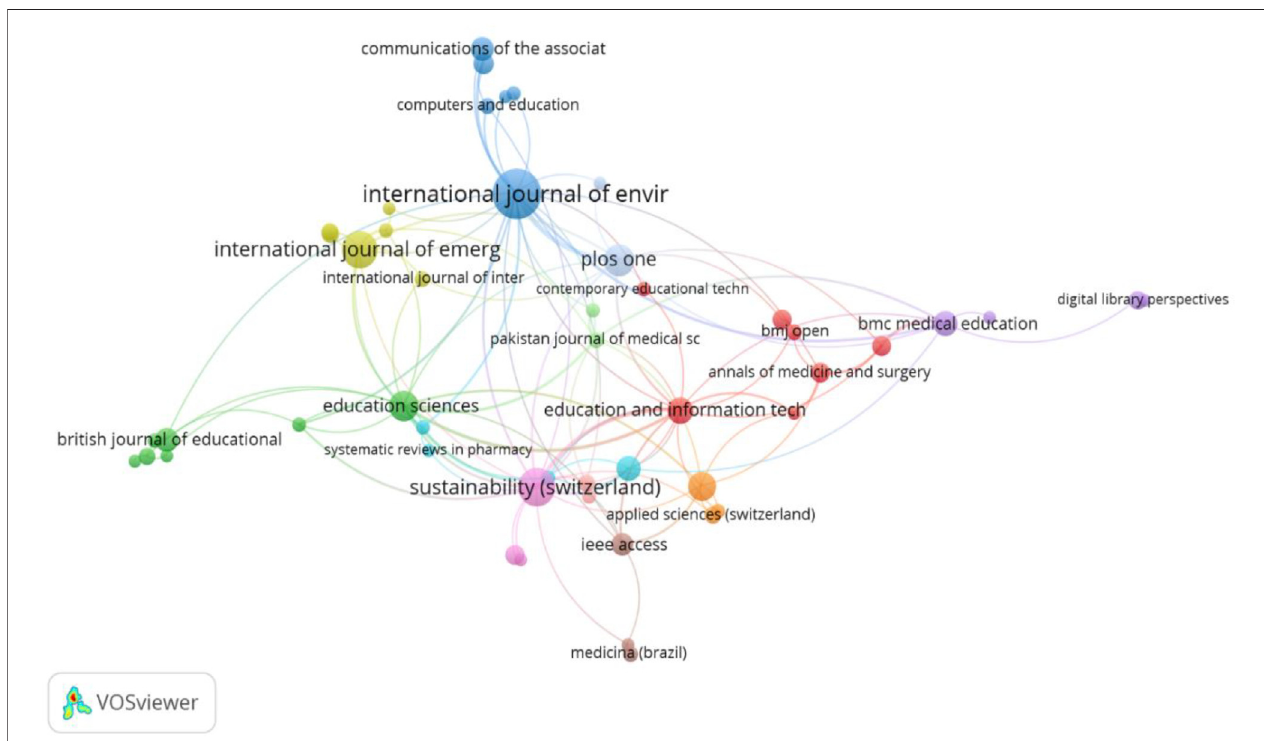
FIGURE 4 | Top 10 journals (Total Publication).